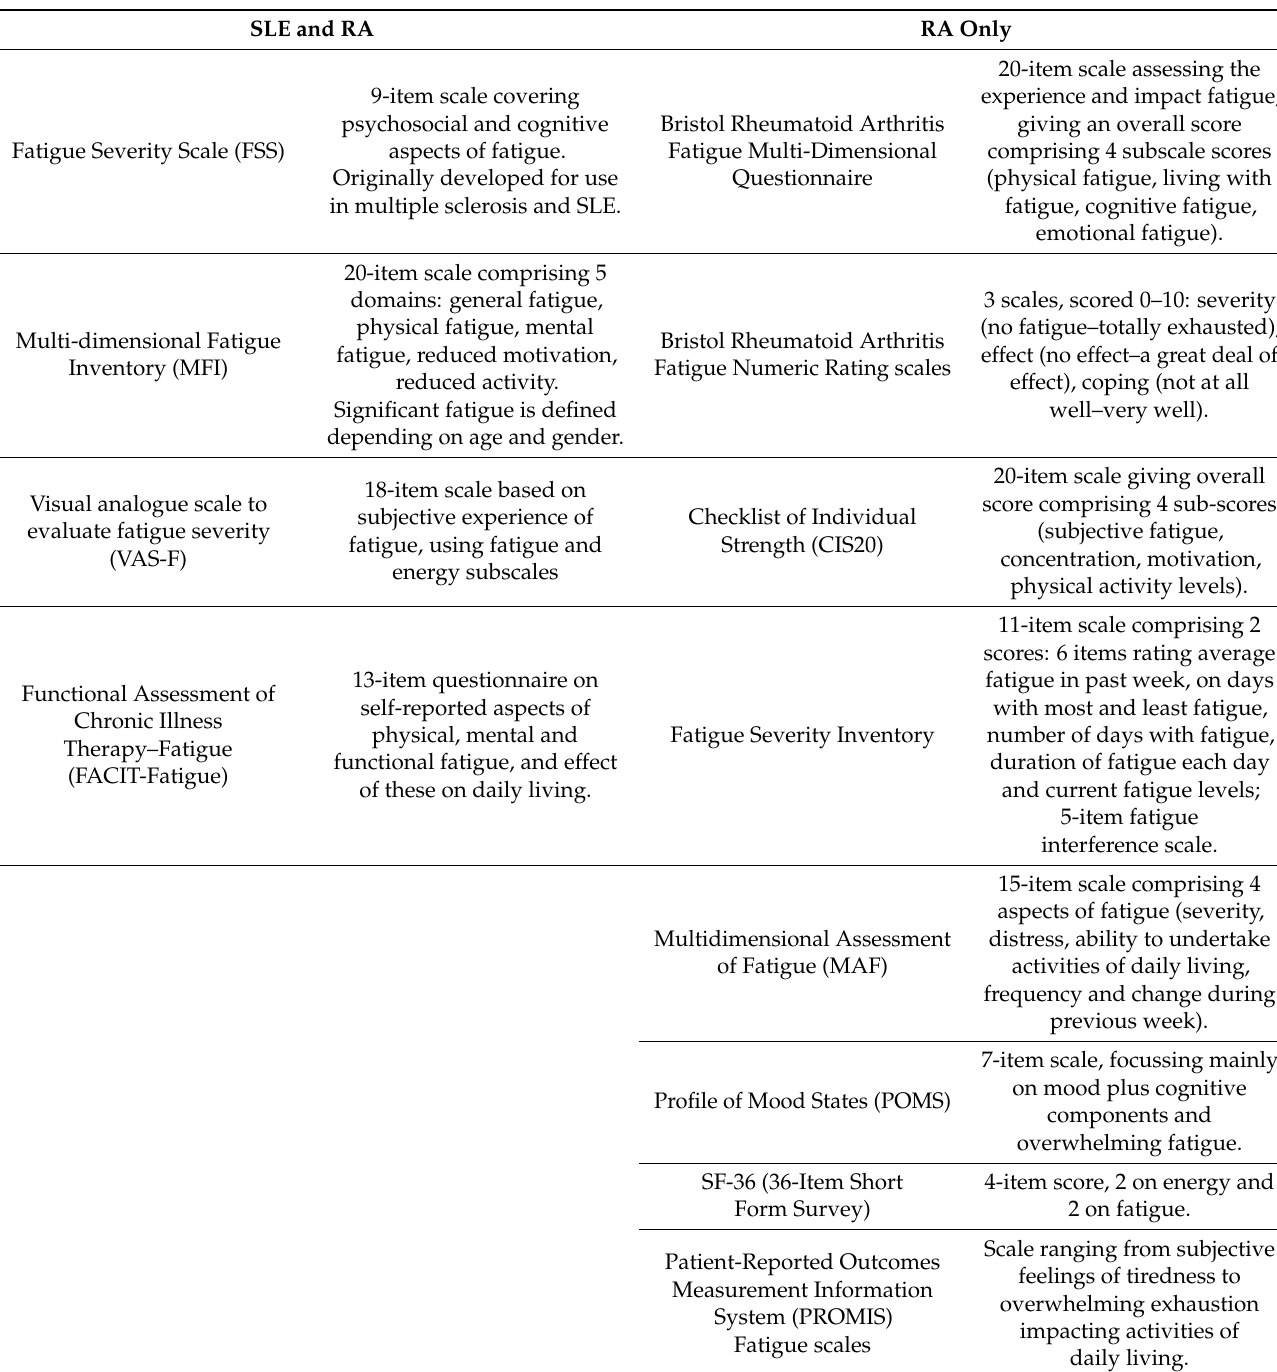
Table 1. Summary of the most commonly used measures for assessment of fatigue used in systemic lupus erythematosus (SLE) and rheumatoid arthritis (RA)